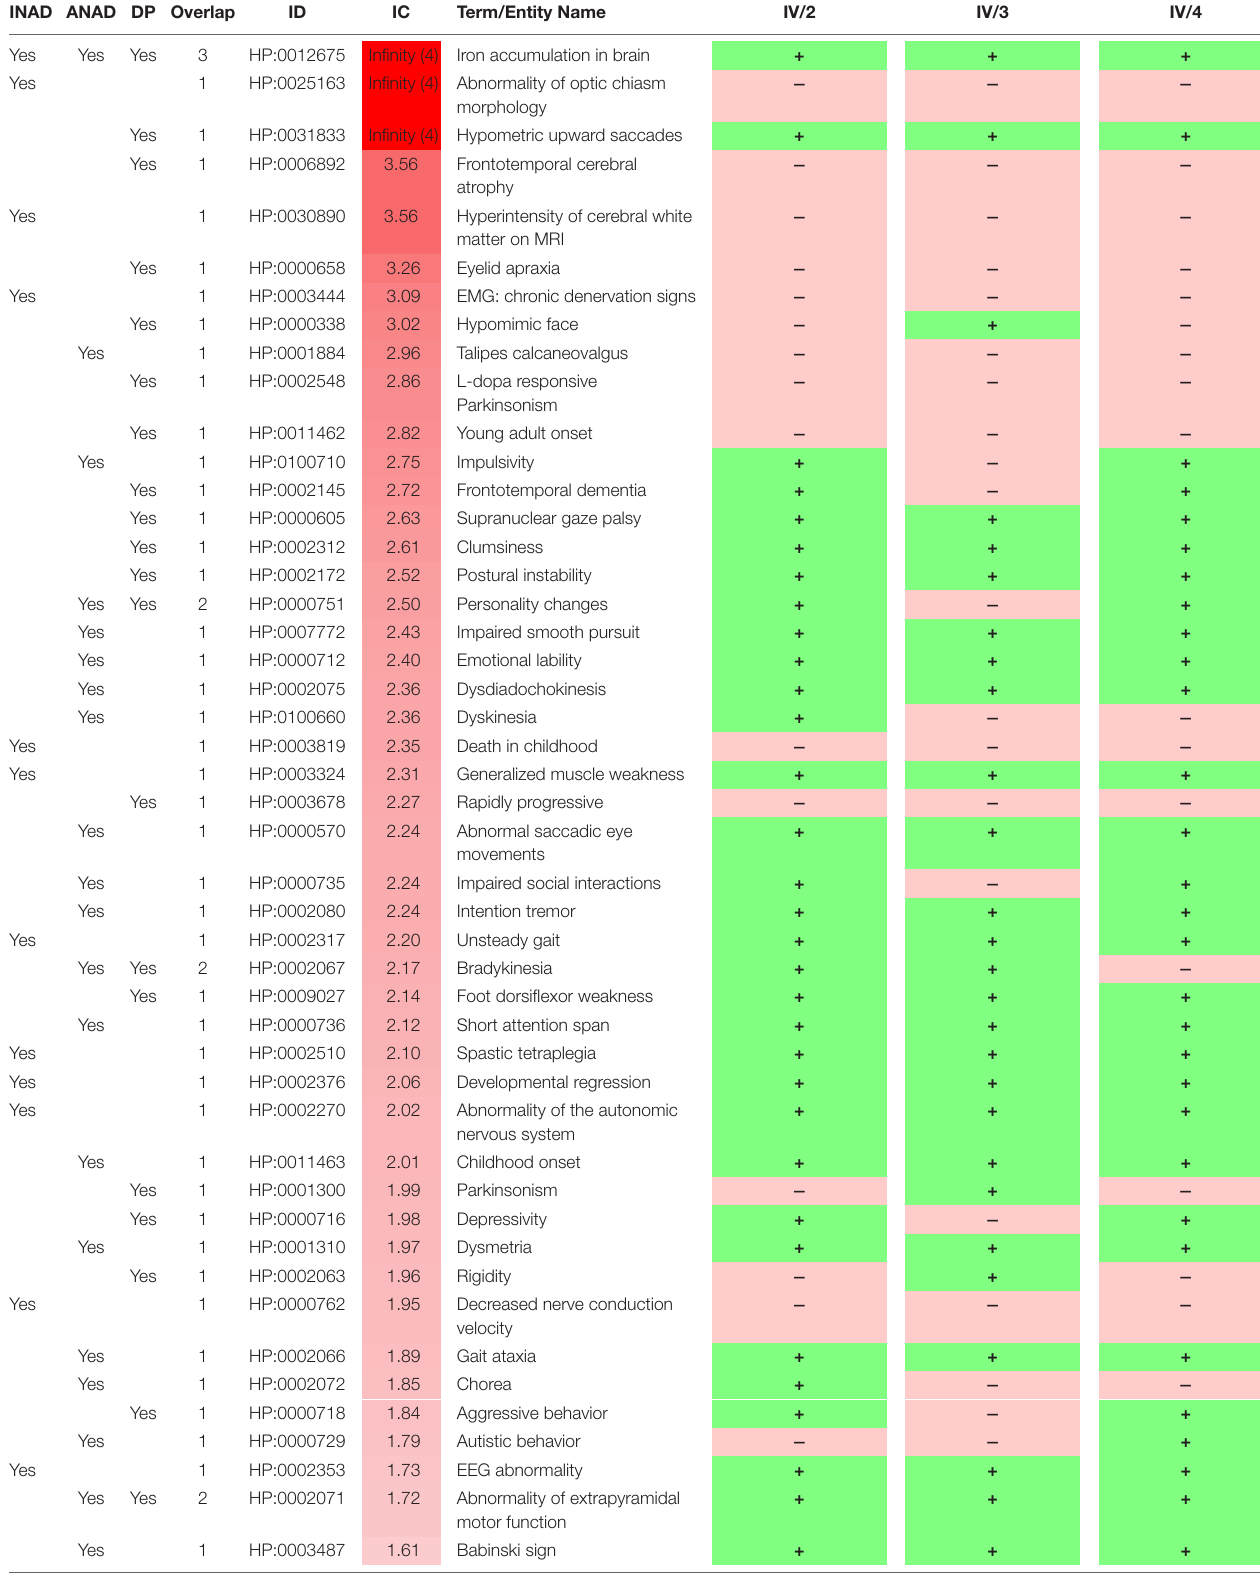
TABLE 2 | The phenotypic overlap of the patients with the allelic disorders associated with PLA2G6. INAD ANAD DP